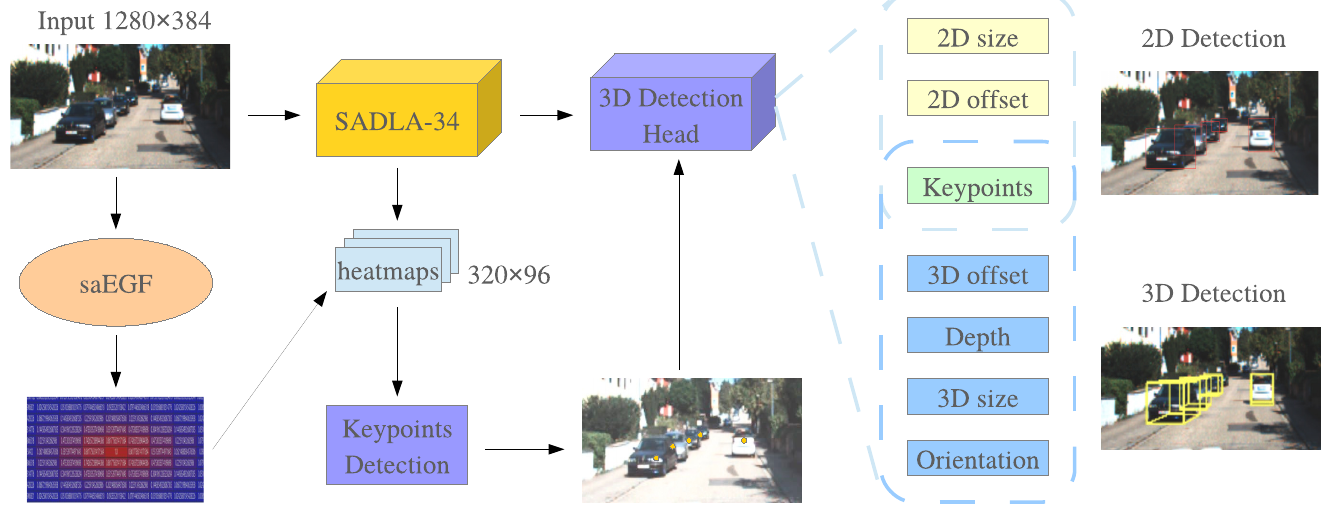
Figure 1. Architecture of the proposed 3D object detection pipeline. A single image serves as input of this framework and will firstly be processed in the SADLA-34 backbone for feature extraction. The outputting heatmaps will be used to detect keypoints of objects, according to the ground truth generated by saEGF module. The predicted keypoints will be inputted into 3D detection head to generate 3D bounding boxes with other regressed 3D properties. Additionally, 2D object detection can also be implemented in this pipeline.